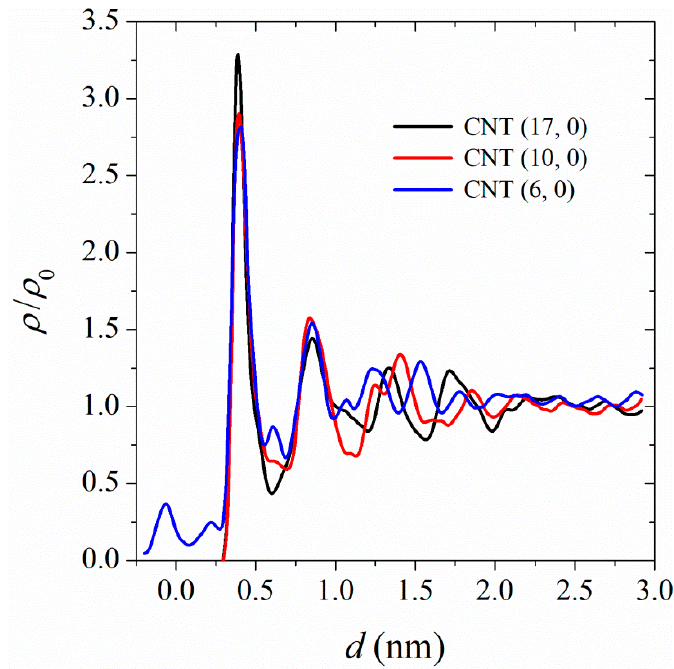
Figure 2. Density profiles for PA-6,6 at the interface of CNT (17, 0), CNT (17, 0), and CNT (17, 0) at 350 K, 101.3 kPa. ρ 0 is the density of the bulk sample (1100 kg/m 3 ).